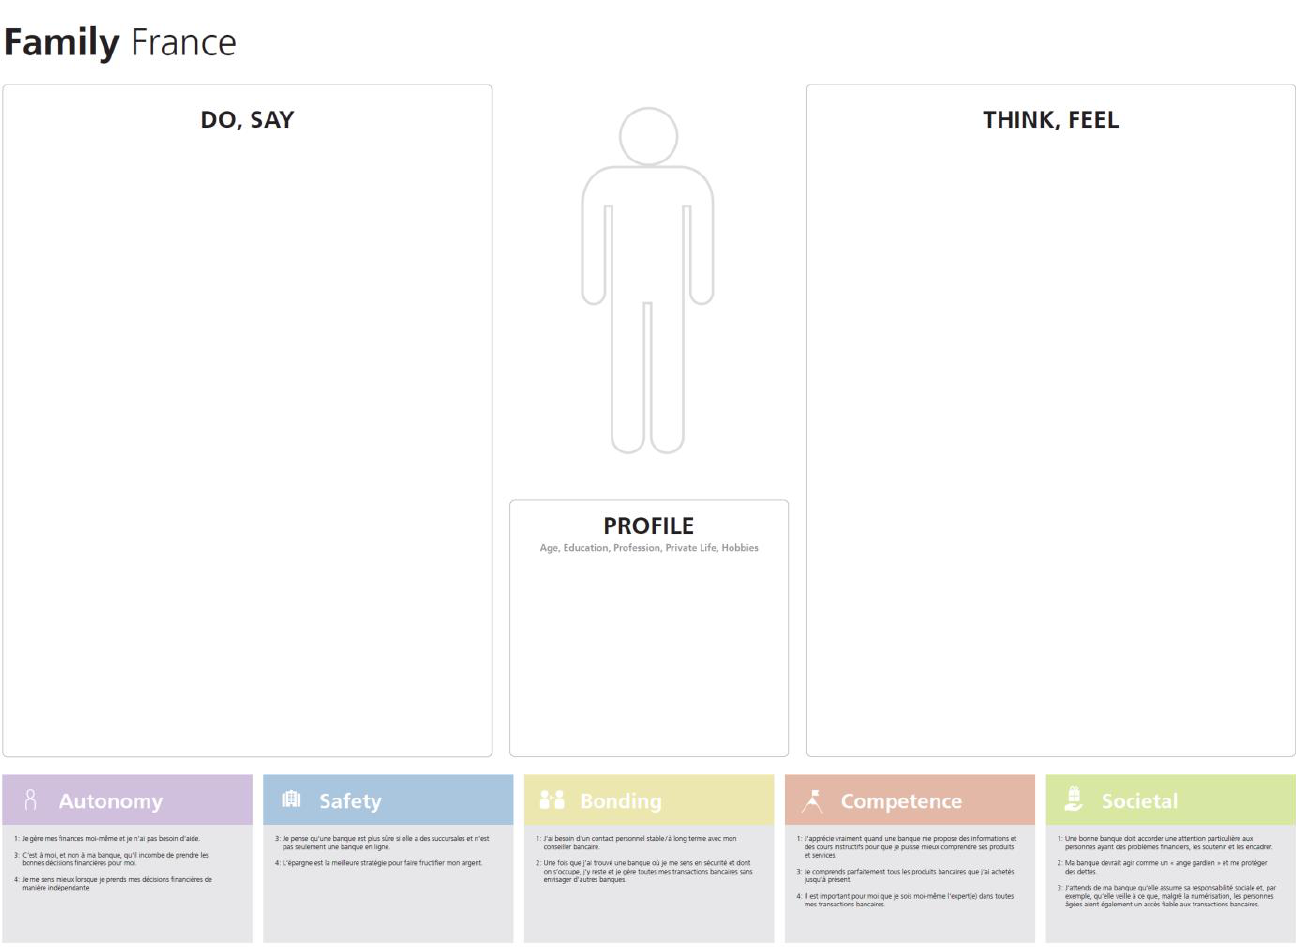
Figure 5. Working with a Needs Empathy Map (Phase II: Empathize).